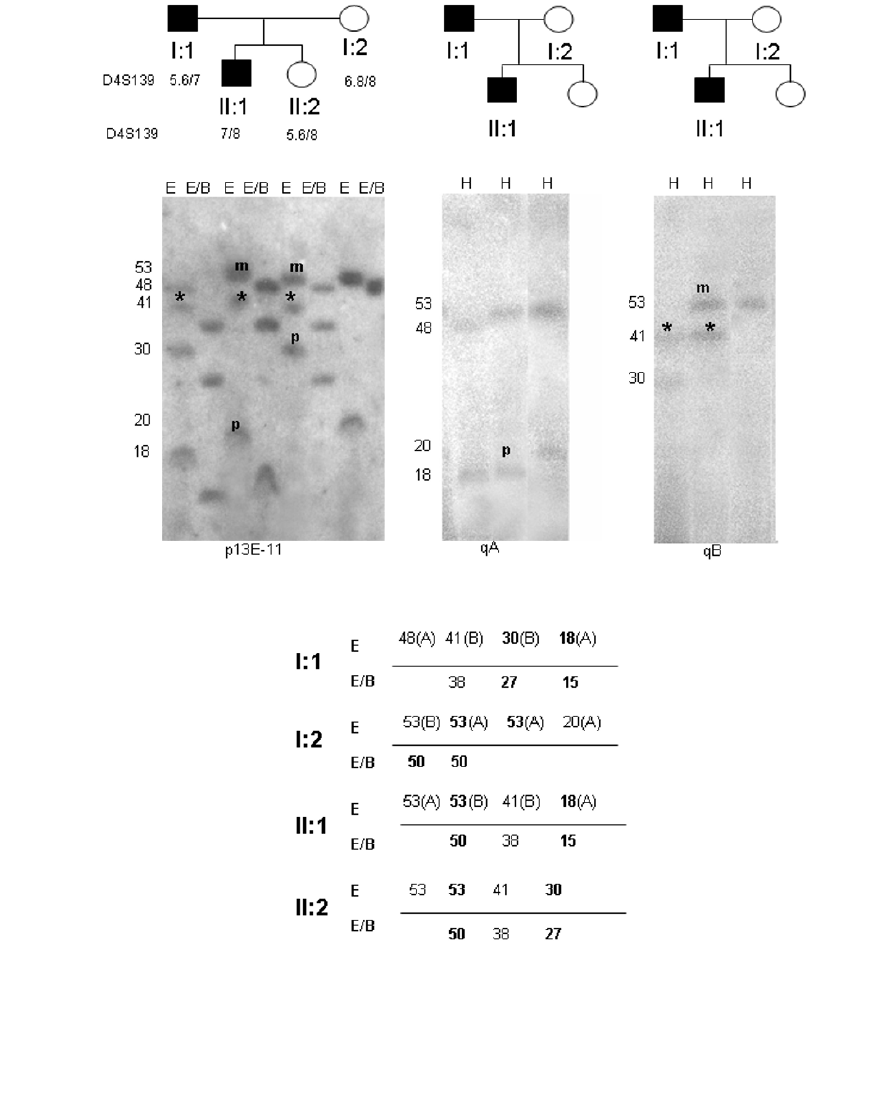
Figure 3 4q and 10q allelic pattern of a FSHD family after hybridization with p13E-11 and qA-qB telomeric markers . a) DNA samples were digested with EcoRI (E) and EcoRI/BlnI (E/B) enzymes, separated with PFGE and hybridized with p13E-11 probe. The proband (I:1) shows a trisomic pattern with two 4q alleles of 18 and 30 kb and two 10q alleles of 41 (BlnI-resistant) (*) and 48 kb (BlnI-sensitive). The affected son (II:1) is also trisomic and inherited from the father the 4q FSHD allele of 18 kb and the10q of 41 kb (*) and from the mother the 4q of 53 kb and a similar size10q allele. The unaffected daughter inherited from the father the 4q allele of 30 kb and the 10q BlnI-resistant allele of 41 kb (*) and from the mother the 4q and 10q frag- ments of 53 kb. The segregation data for the probe D4S139 showed that II:1 and II:2 inherited the same 4q allele from the mother (I:2), but different 4q alleles from the father (I:1). This suggest that the BlnI-resistant allele of 41 kb is a 10q variant; b) DNA samples were digested with HindIII (H), separated with PFGE and subsequently hybridized with qA and qB probes: the short 4q allele (18 kb) is qA type, while the 4q allele of 30 kb is qB type. All the standard 10q alleles of 48, 53 and 20 kb have qA type telomeres, while the variant 10q allele of 41 kb is qB type. This variant 10q allele carries the Bln1-resistant repeat array and the distal telomeric sequence of 4q-type. The 10q origin of this allele is confirmed by absence of segregation with D4S139 probe. The DNA sample of the subject II:2 was not sufficient for qA/qB Southern Blot analysis and it was not included in figure 3. In the diagram below the alleles observed after EcoRI and EcoRI/BlnI digestion are shown: the 4q alleles are in bold and the telomeres (A or B) are in